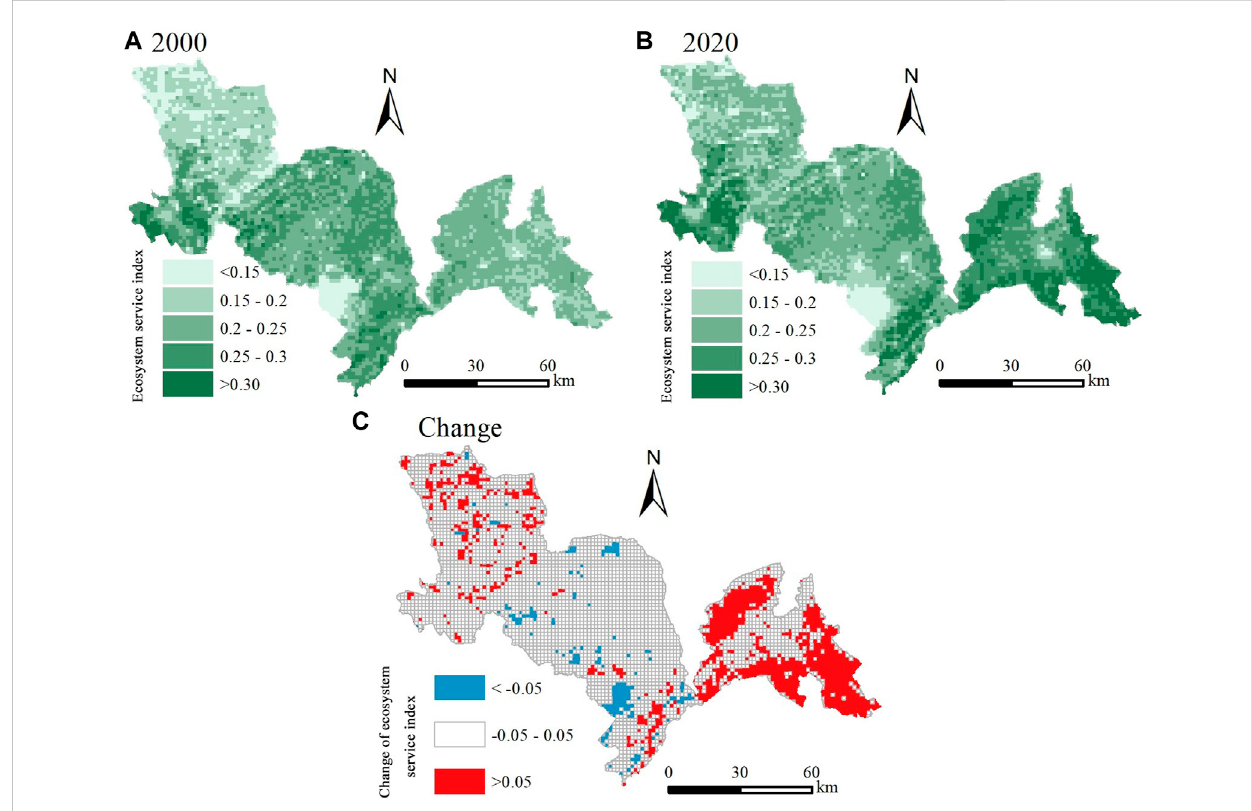
FIGURE 5 Ecosystem service index in (A) 2000 and (B) 2020, and (C) its temporal